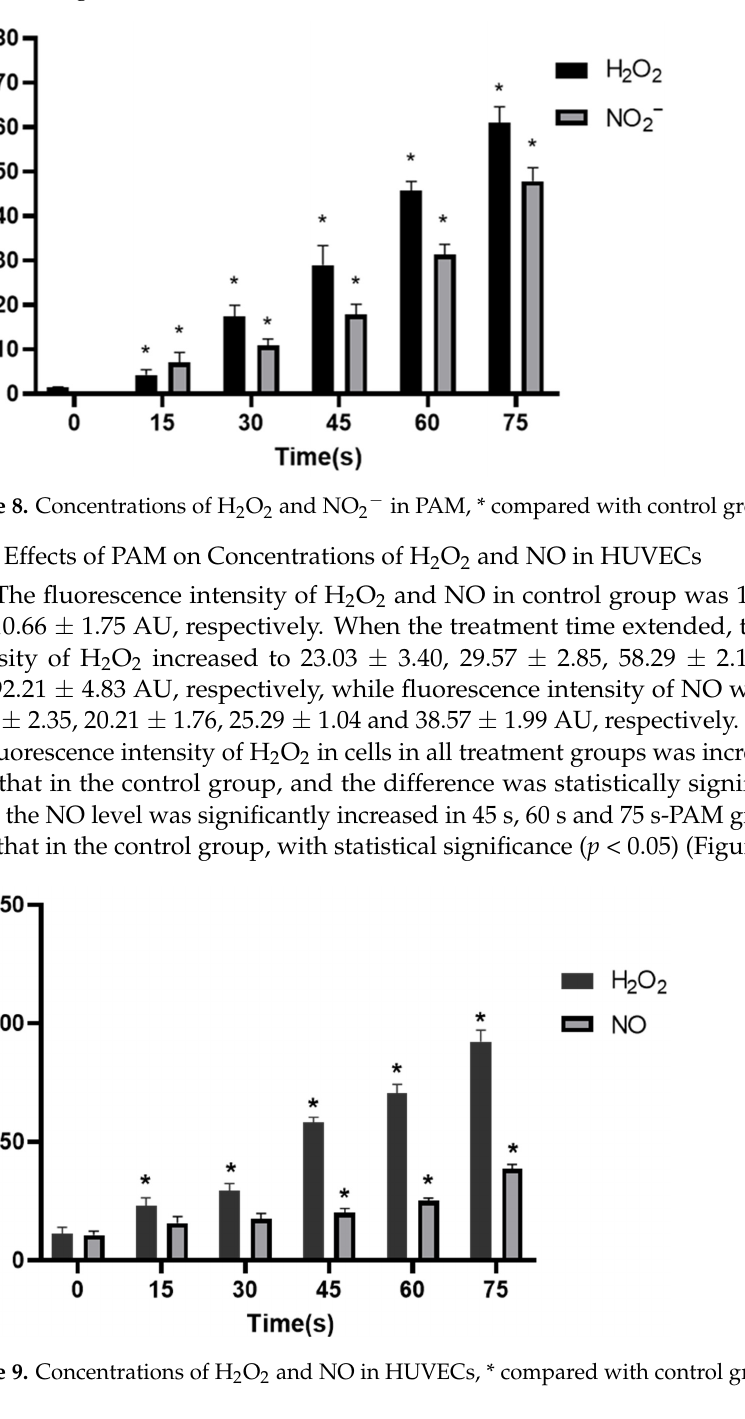
Figure 7. ( a ) Protein expression bands detected with Western blotting. ( b ) Statistical results, * com- pared with control group (0 s) p < 0.05.